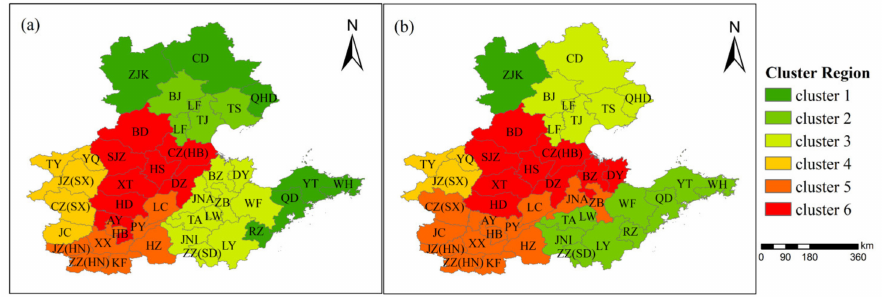
Figure 4. Clustering results based on daily PM 2.5 concentrations of Euclidean distance ( a ) and Pearson’s correlation distance ( b ) in